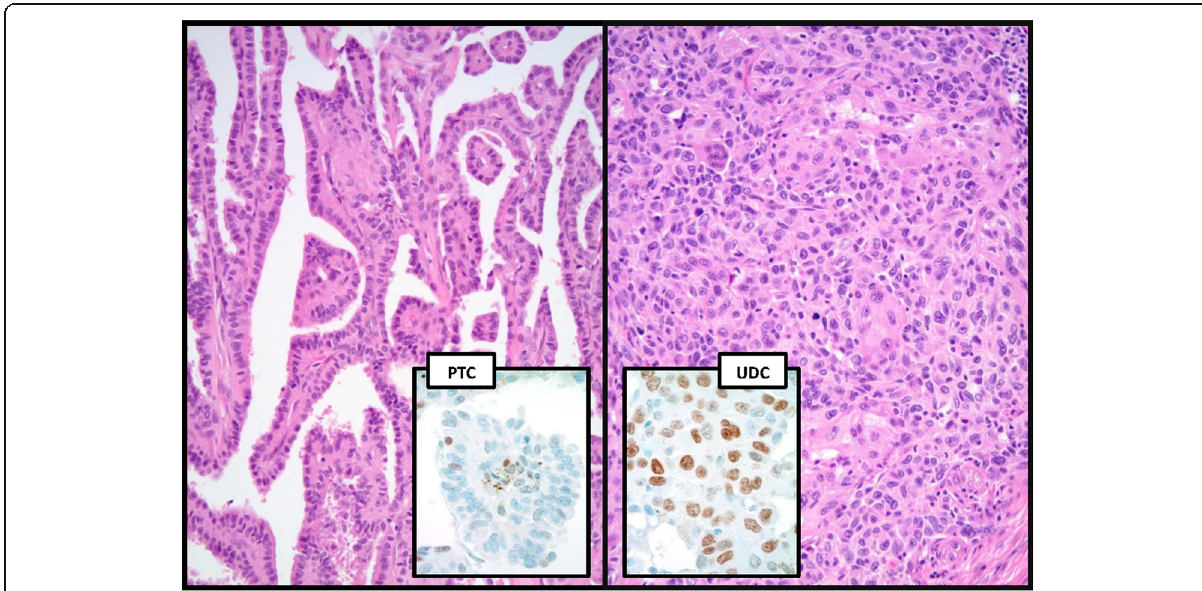
Fig. 2 cMYC overexpression in a UDC developing out of a PTC (representative whole slide images). cMYC nuclear overexpression as seen in one of the UDC cases concomitantly developing out of a PTC. The PTC case showed >25% cells staining weakly for cMYC (scores 2 & +1, respectively) with UDC developing in vicinity showing 3 & +2 score. H&E background photomicrographs were originally taken at 20× magnification, and the cMYC IHC inserts were taken at 60X magnification